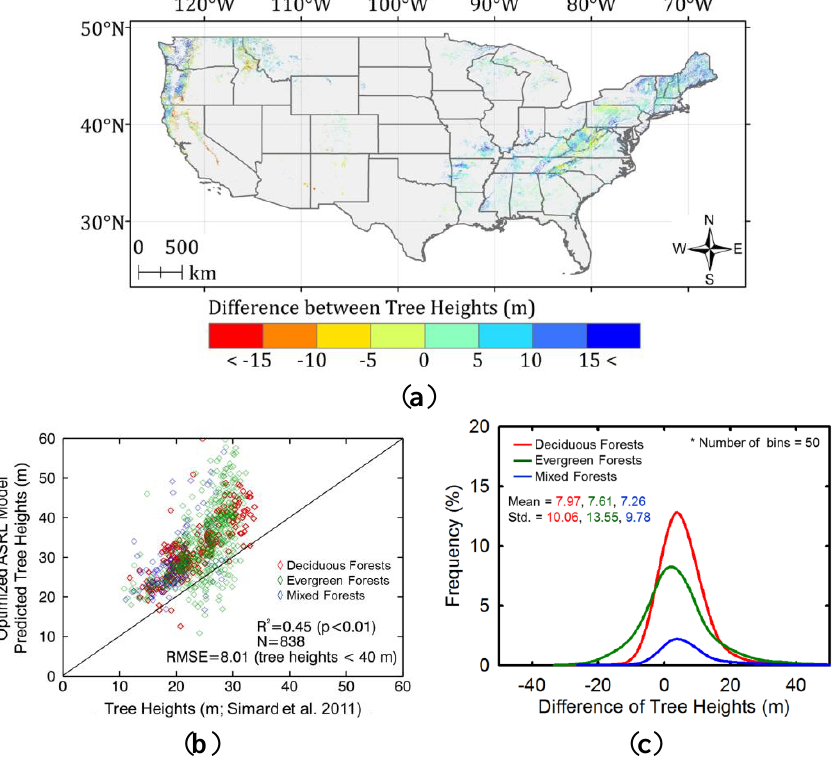
Figure 7. Inter-comparison of tree heights predicted by the optimized ASRL model with forest canopy heights from Simard et al. [1]: ( a ) Spatial map showing differences in tree heights ( H − H ). ( b ) Comparison at the climatic zone level. ( c ) Pixel level opt ASRL Simard difference histograms ( H − H ) for the three forest types considered in this study. opt ASRL Simard Number of bins of histograms is 50. Frequencies have been normalized by total grids (frequency %).